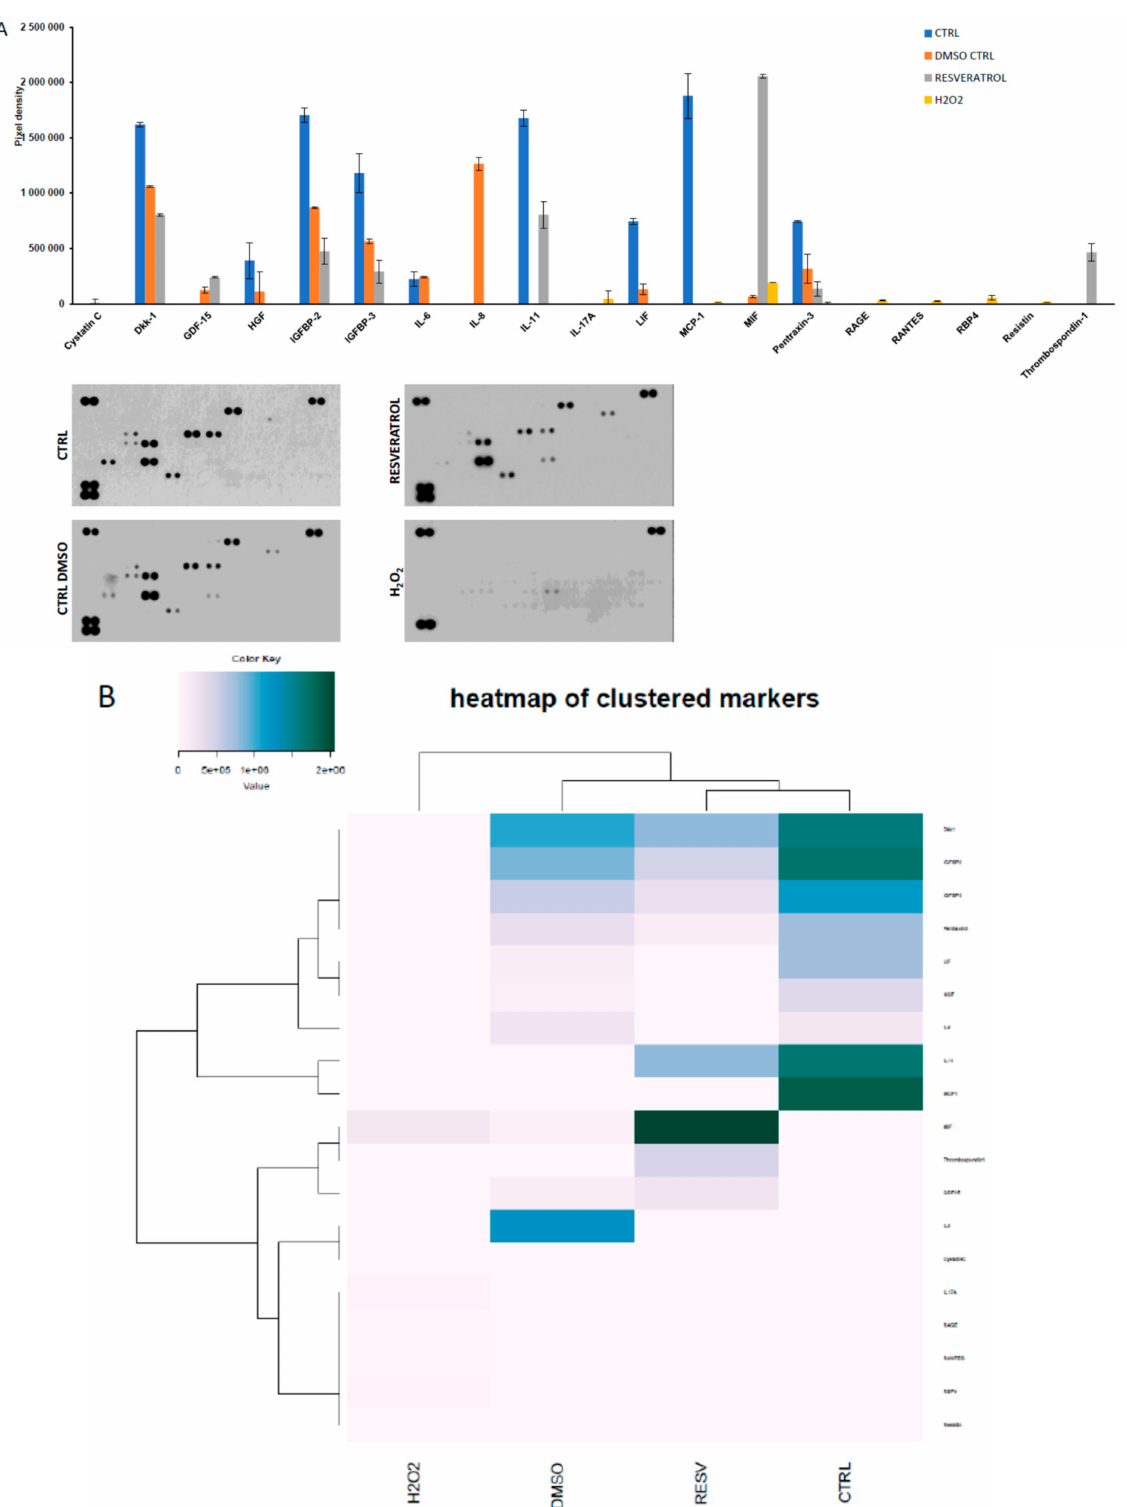
Figure 4. Protein secretome of ARPE-19 cells treated by oxidative stress inducer hydrogen peroxide (H 2 O 2 ) and resveratrol ( A ) and hierarchical clustering of markers on a heatmap ( B